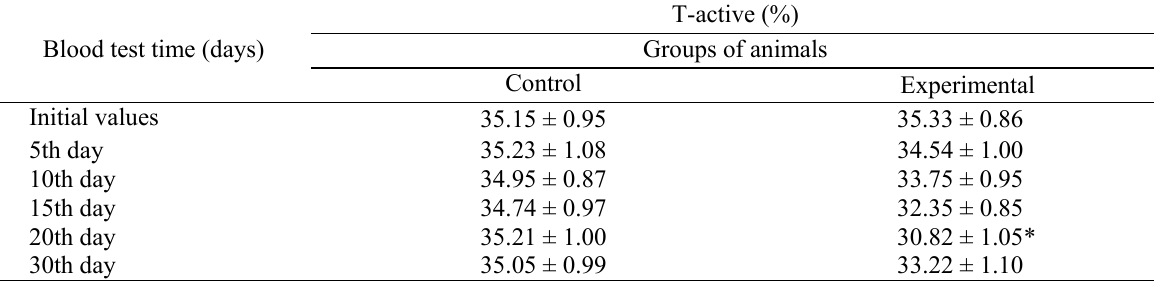
The number of T-active lymphocytes in the blood of bulls under the influence of chronic cadmium toxicosis (М ± m, n = 5)